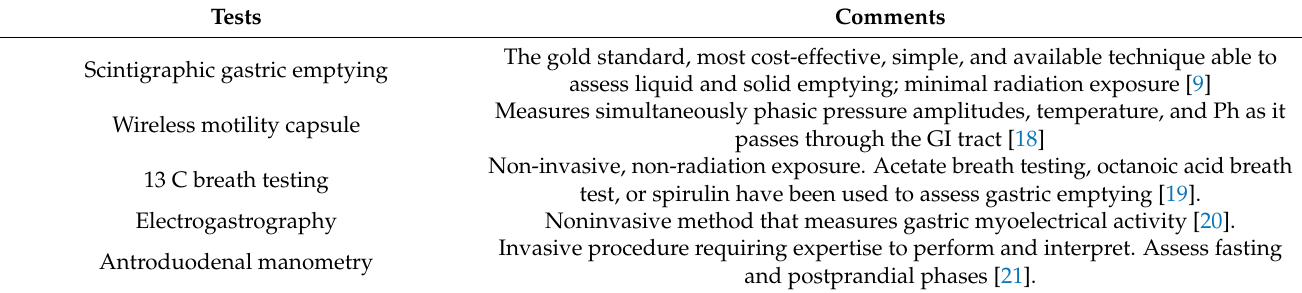
Table 1. Tests used for the assessment of gastric motility.